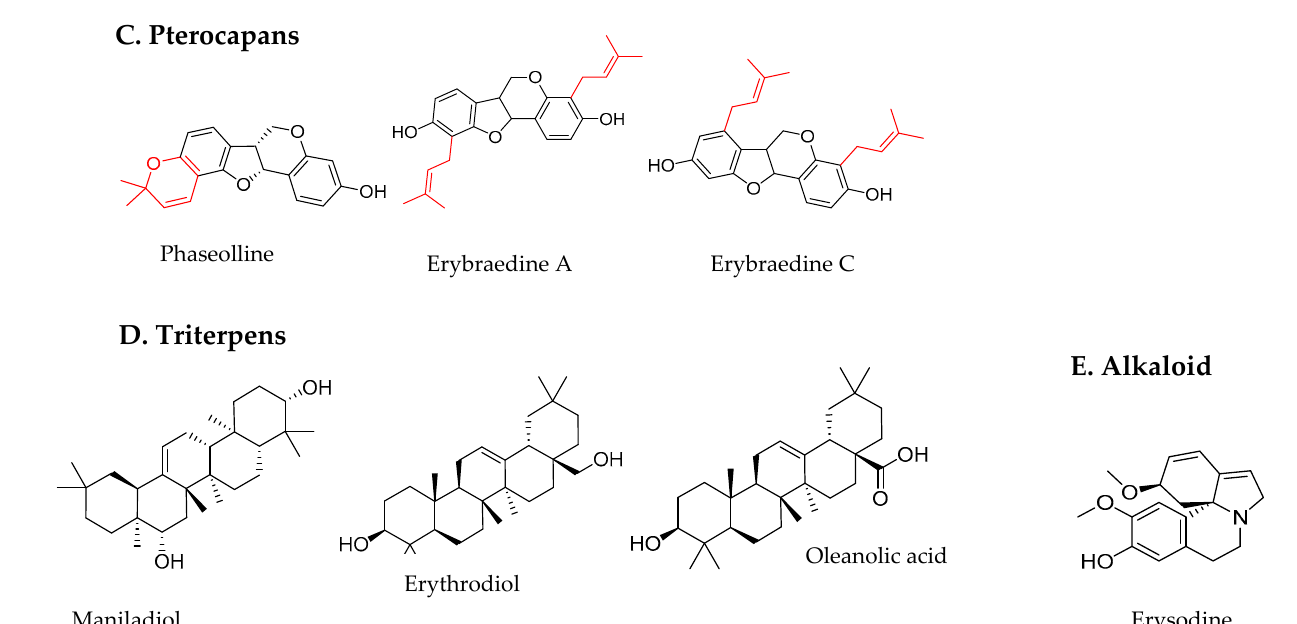
Figure 1. Chemical structures of potential anticancerous compounds isolated from E. senegalensis. Flavonoids and isoflavonoids are all prenylated and the prenyl group is highlighted in red. The first 4 isoflavonoids are dimethylpyrano-isoflavonoids.